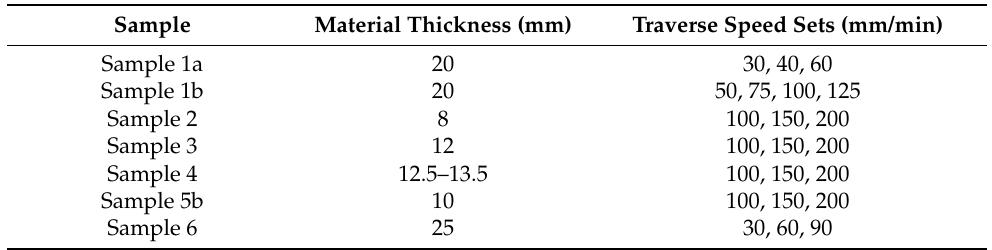
Table 3. Summary of traverse speed sets for examined material samples and samples’